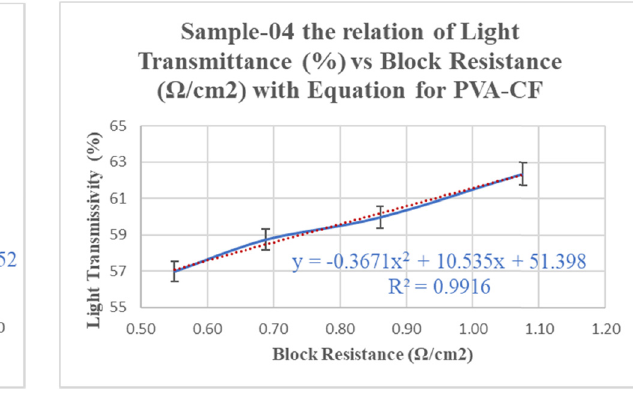
Figure 21: Sample - 01 ( CF:PVA = 0.1:30 ) light transmittance ( % ) versus block resistance ( k Ω ) with equation for PVA - CF. The dotted lines represent the polynomial fi tted curve and the linear fi tted line.